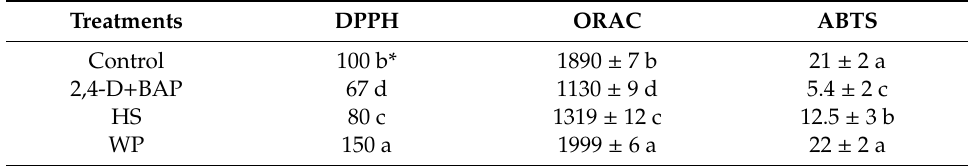
Table 6. 1,1-diphenyl-2-picrylhydrazyl radical scavenging activity (DPPH, % inhibition),